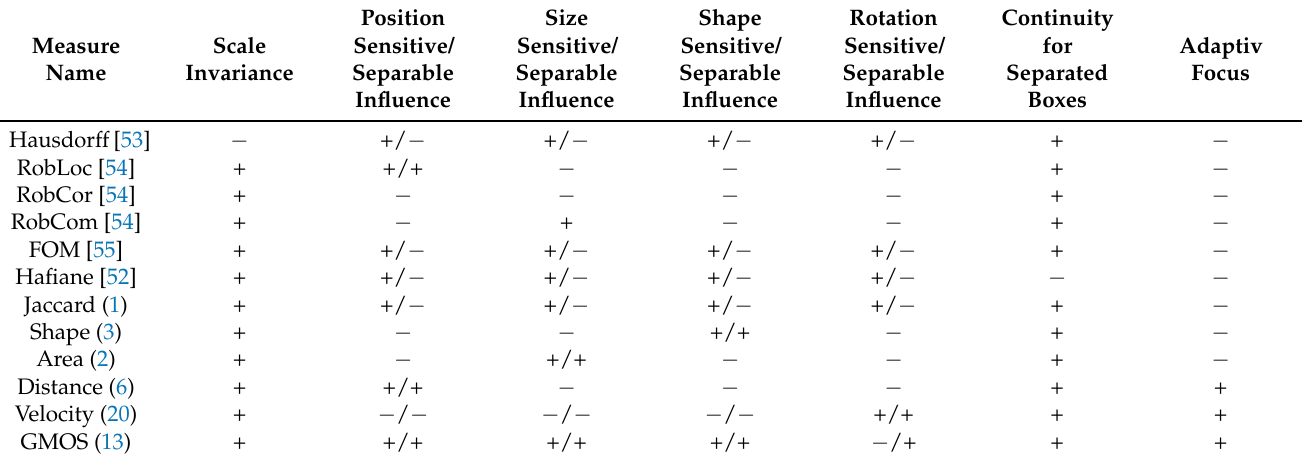
Table 4. Comparison of features provided by quality measures for bounding box